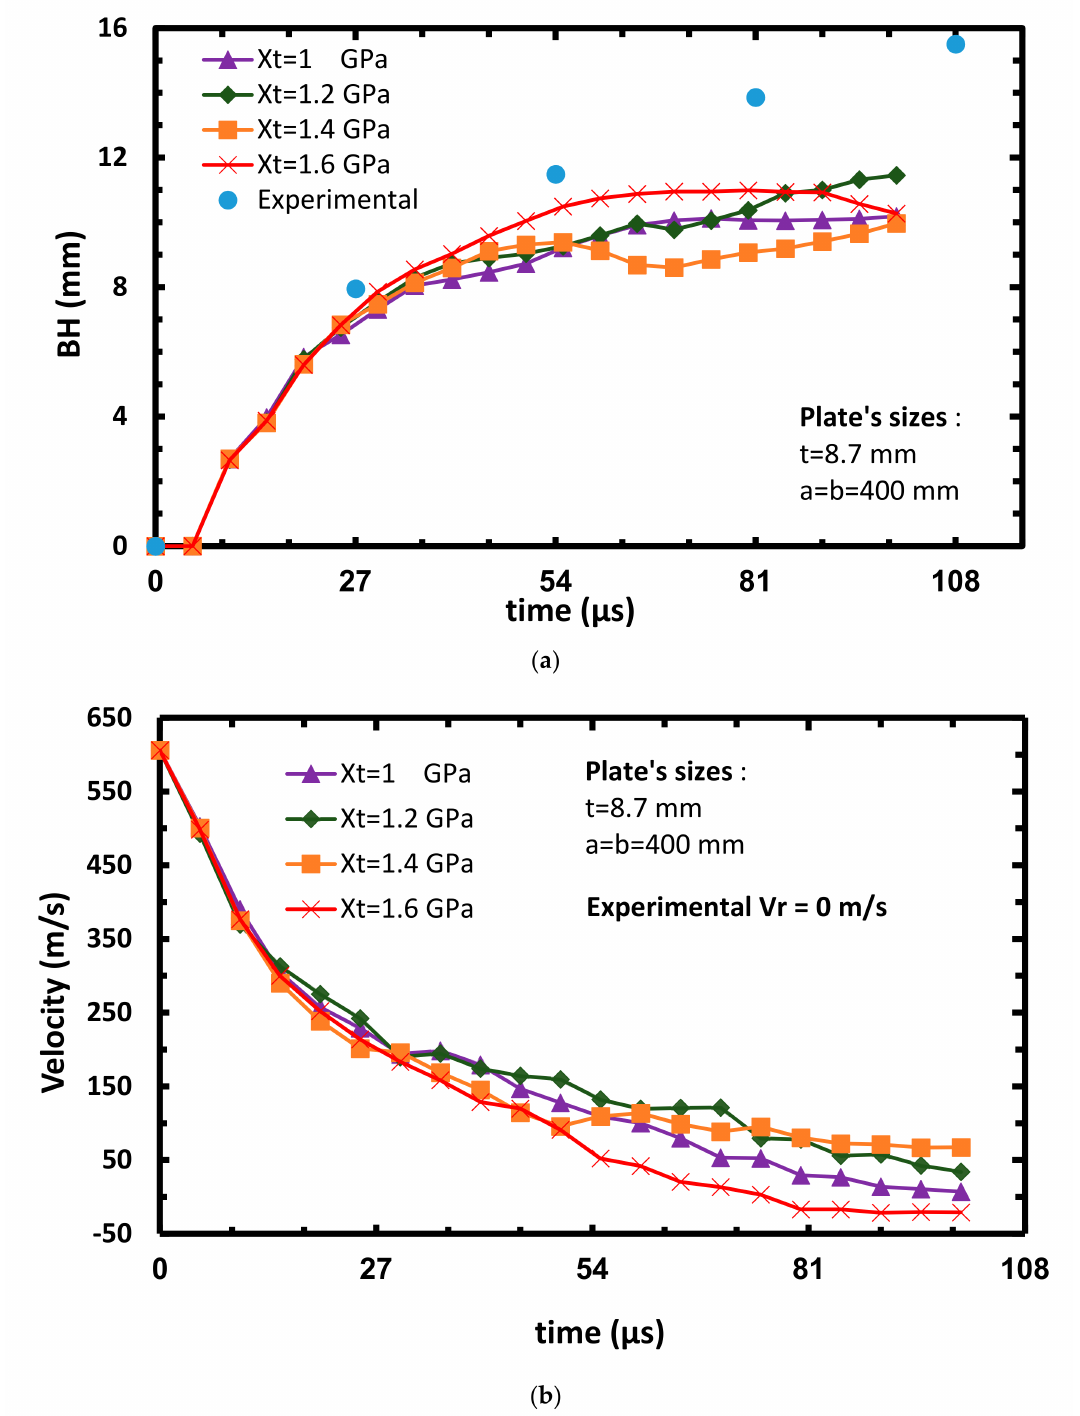
Figure 6. Plate’s bulge height ( a ) and projectile’s velocity ( b ) vs. time at varying Xt, Vinitial = 606